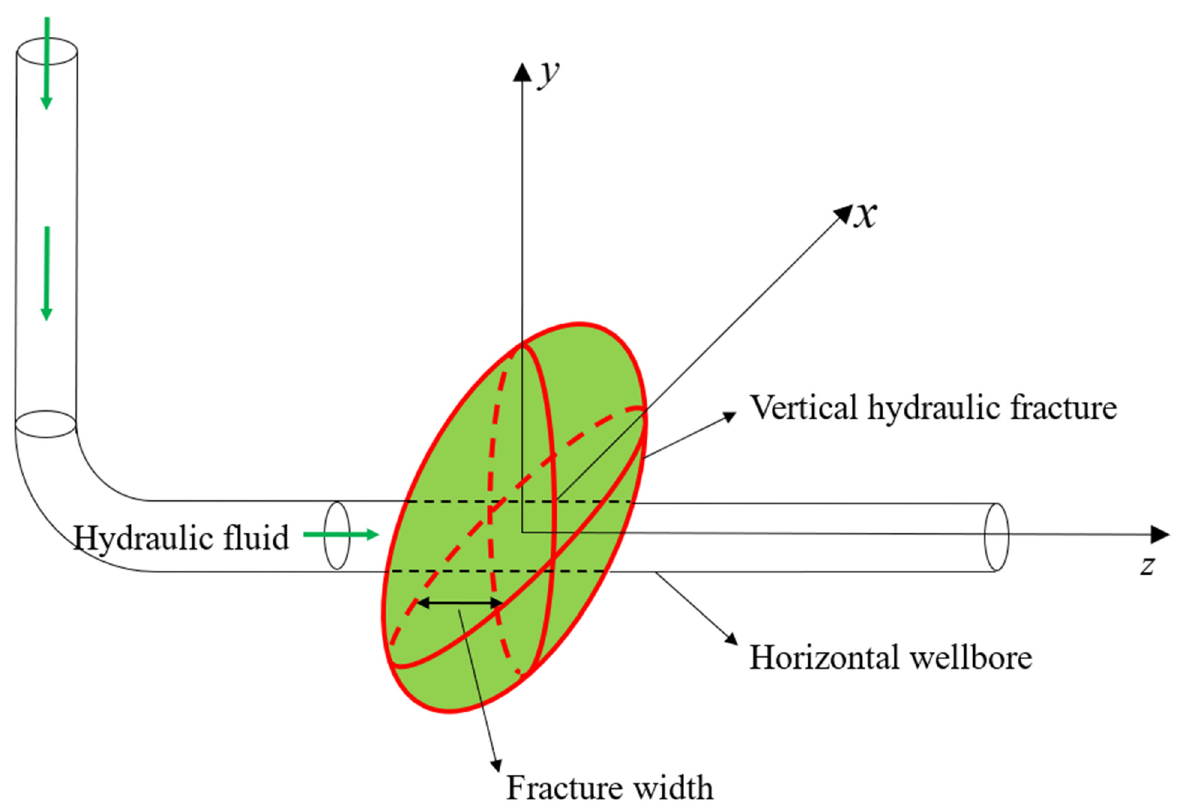
Figure 1. A planar-3D hydraulic fracture across a horizontal wellbore in a medium with inhomoge- neous fracture toughness.